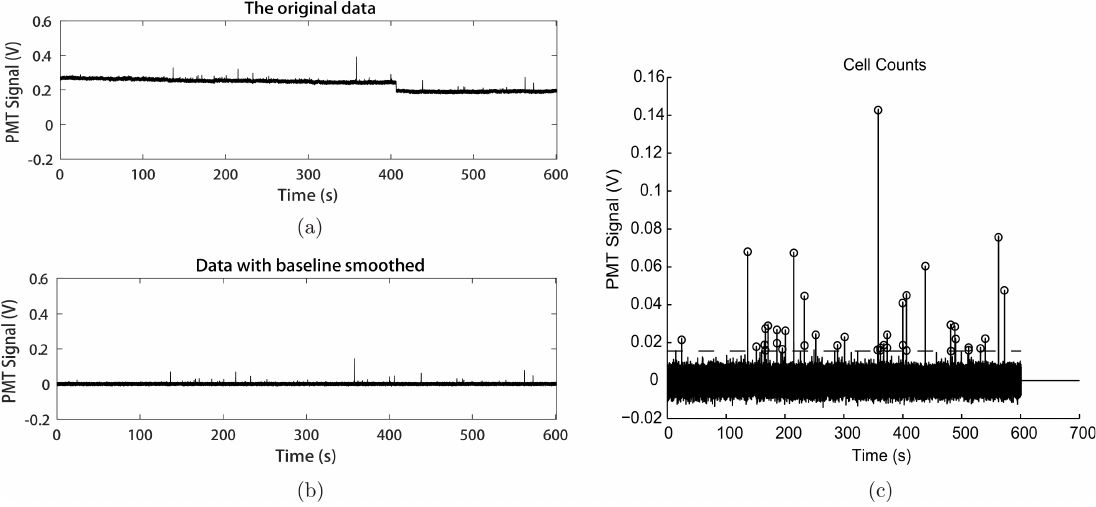
Fig. 6. A signal with abrupt baseline level change is processed after correcting baseline drift. (a) The baseline level of the original signal changes at around 406 s. (b) The smoothed signal has a less °uctuating baseline level. (c) Cell peaks after correcting baseline drift shows the counting result of